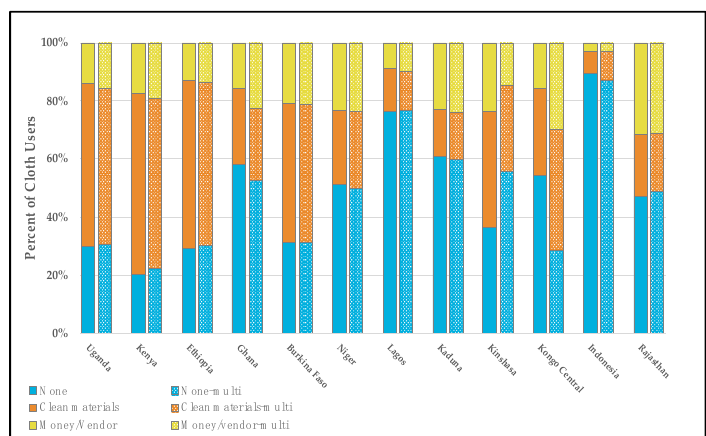
Figure 1. Reported menstrual material needs of menstrual pad users whose pad use was categorized using a single-response variable denoting exclusive pad use (left) and a multi-response variable denoting any pad use (right, patterned). Response options included no material needs (blue, bottom), clean materials (orange, middle), and money/vendor (yellow, top).